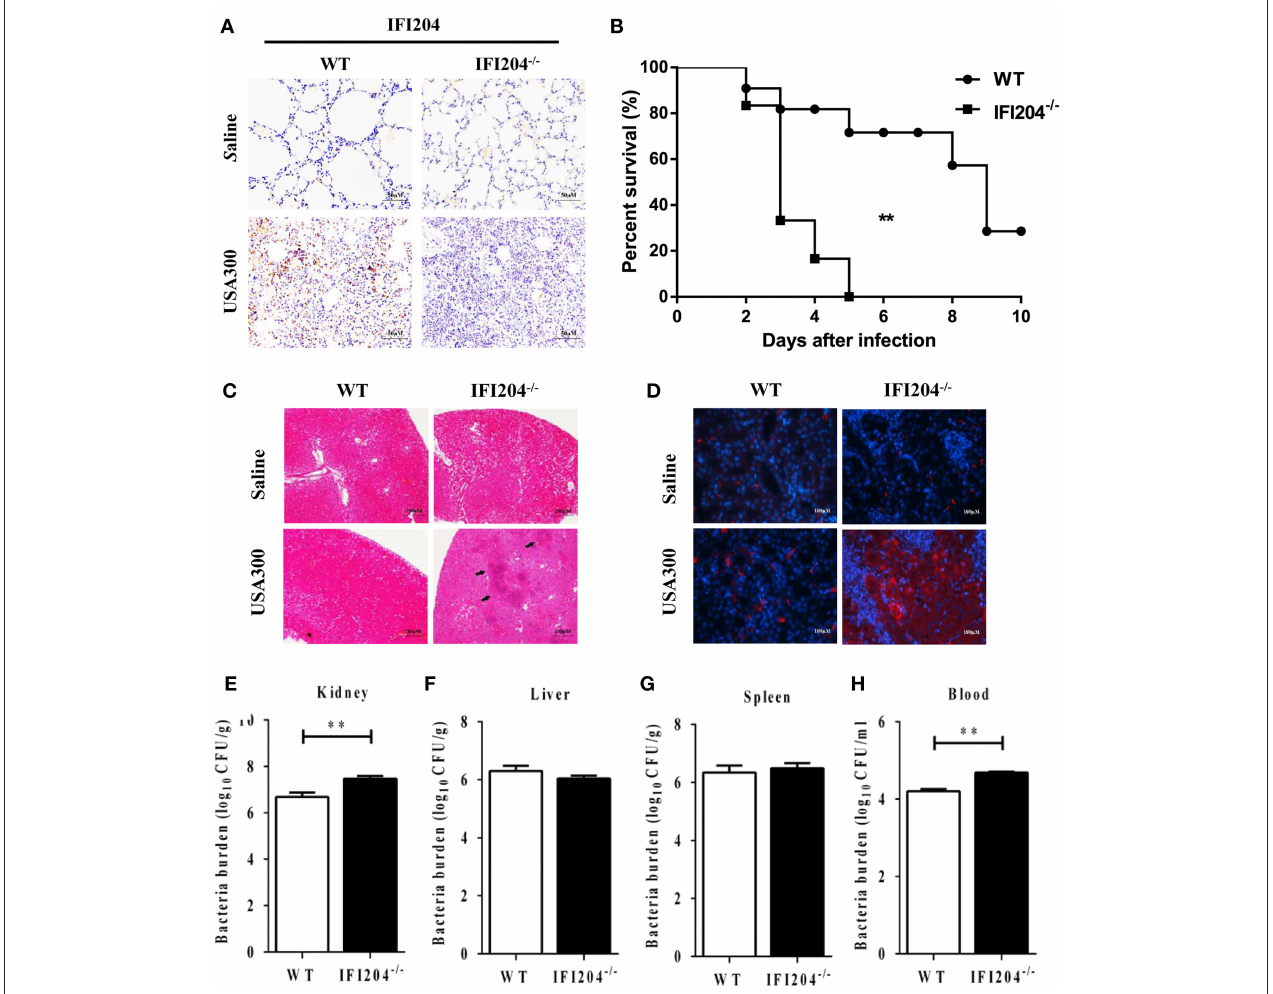
FIGURE 3 | IFI204-deficient mice displayed increased susceptibility to Staphylococcus systemic infection. (A) Lung sections were stained with anti-IFI204. (B) WT ( n = 15) and IFI204 − / − ( n = 13) mice were infected i.v with 1 × 10 8 CFU of Staphylococcus . The animals were monitored daily up to 10 days for survival. The Kaplan-Meier and log-rank methods were used to analyze survival rates. (C,D) Kidney tissues were collected from WT and IFI204 − / − mice at 48 hpi ( n = 5 each group). Kidney injury was assessed by hematoxylin-eosin staining (C) and terminal deoxynucleotidyl transferase dUTP nick end labeling (TUNEL) histology (D) . Representative results are depicted. (E–H) Bacterial loads in kidney, liver, spleen, and blood of WT ( n = 8) and IFI204 − / − ( n = 10) at 20 hpi were determined. All data are shown as mean ± SEM. Student’s t -test was performed. ** p <